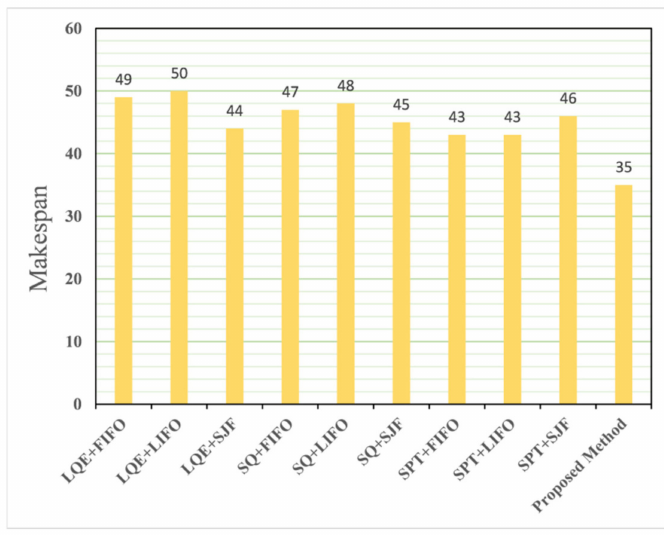
Figure 11. Comparison between various